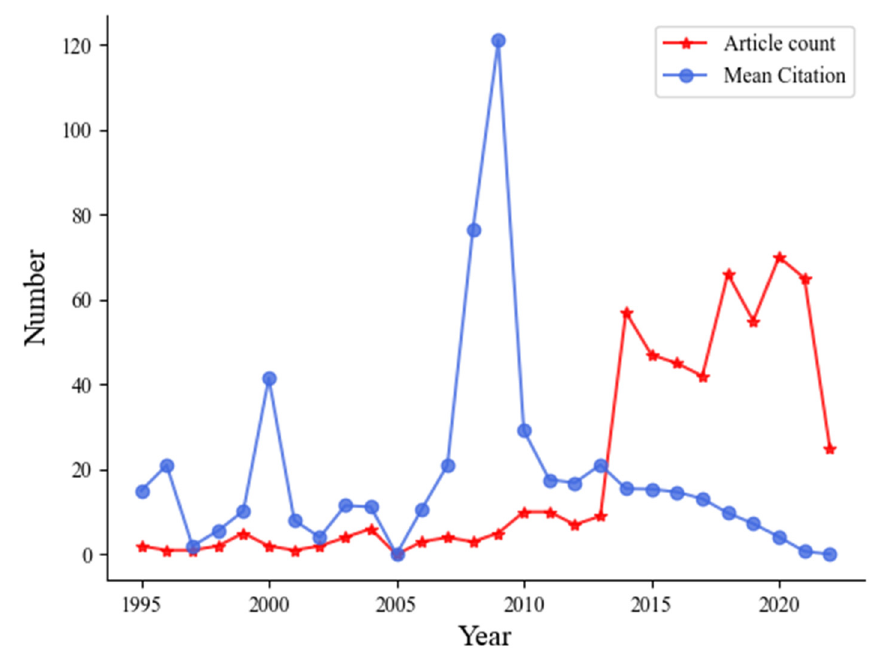
Figure 2. Publishing trends of neuroscience in the field of education.